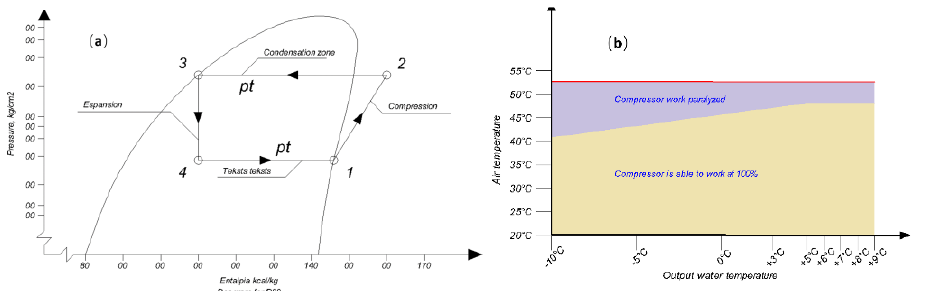
Figure 5. Enthalpy diagram. ( a ) Enthalpy of theoretical cycle ( b) Compressor theoretical working curve